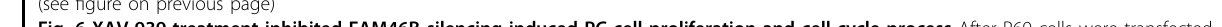
Fig. 6 XAV-939 treatment inhibited FAM46B silencing-induced PC cell proliferation and cell cycle process After P69 cells were transfected with siFAM46B-1 with or without XAV-939 treatment (20 μ M ), cell proliferation and cell cycle progression were measured by CCK-8 assay a and fl ow cytometry b , c , and the expression of C-myc, Cyclin D1, and β -catenin was measured by western blotting d , e . PC-3 cells transfected with pLVX-Puro- FAM46B were treated with MG132 (50 μ M ) for 4 h, and the expression of FAM46B and β -catenin proteins was measured by western blotting f , g . β -